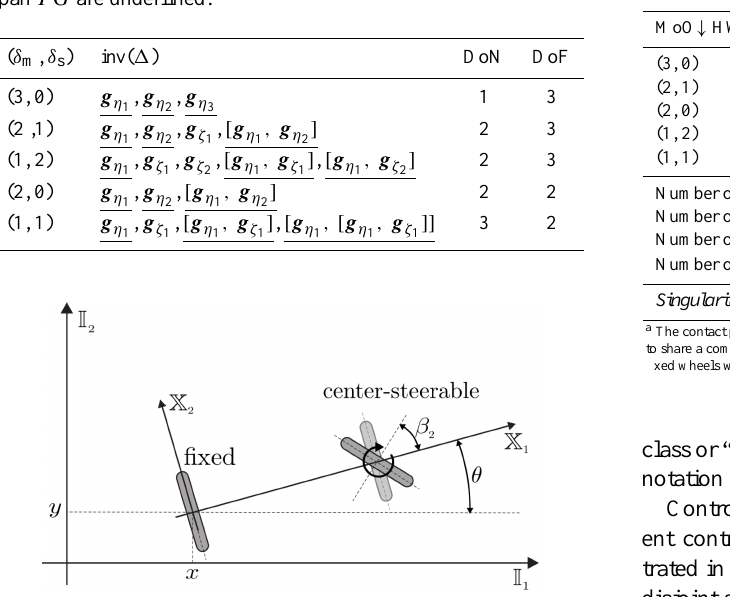
Table 2. The relation of hardware designs and modes of